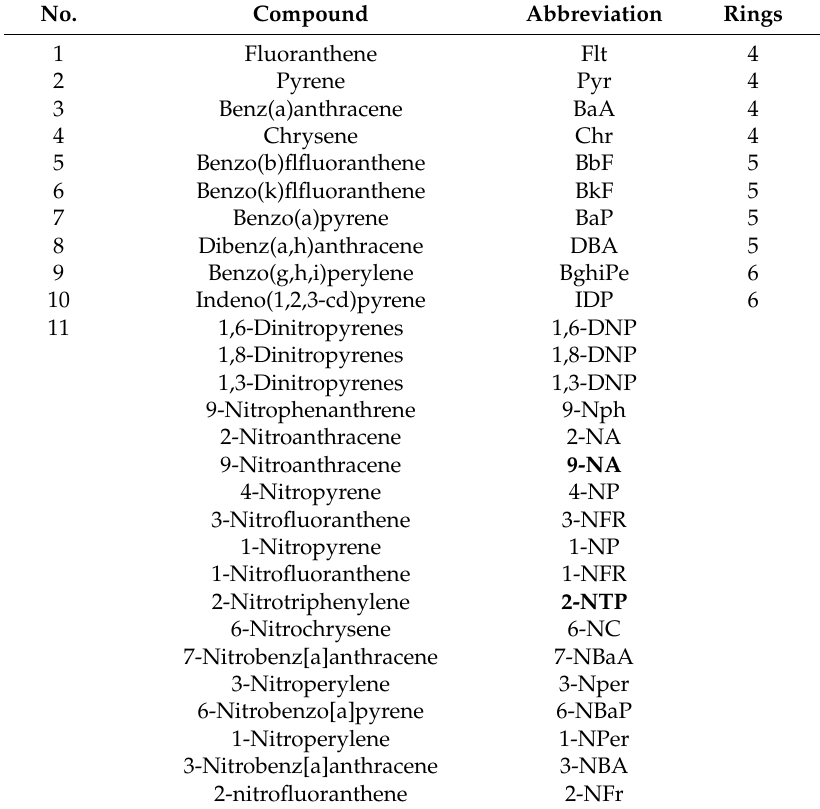
Table 1. The detected compounds of PAHs and NPAHs in this